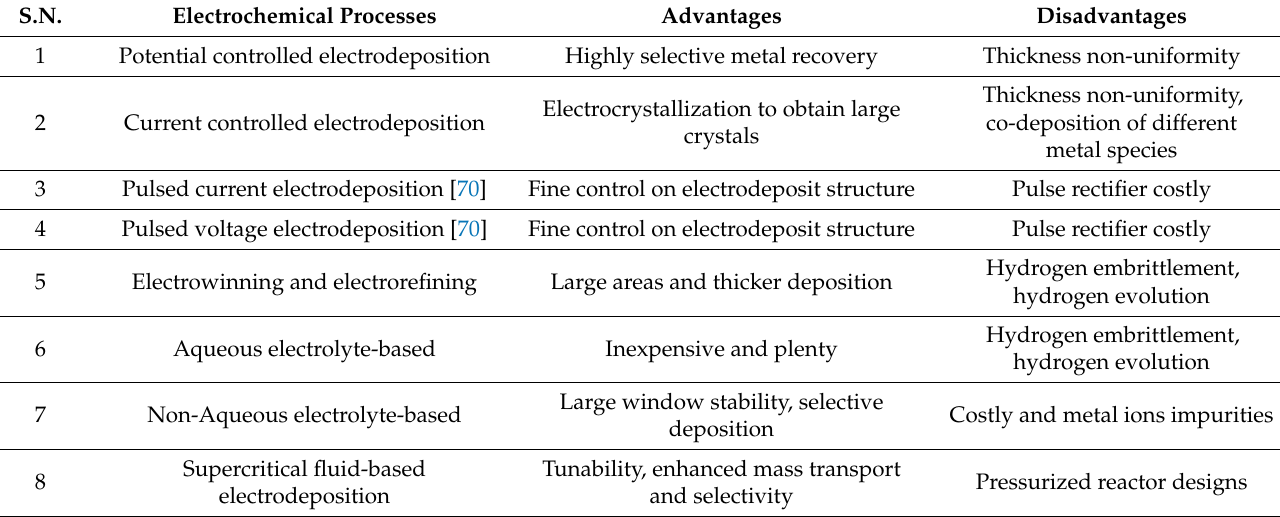
Table 4. Advantages and disadvantages of electrochemical processes during metal recovery.